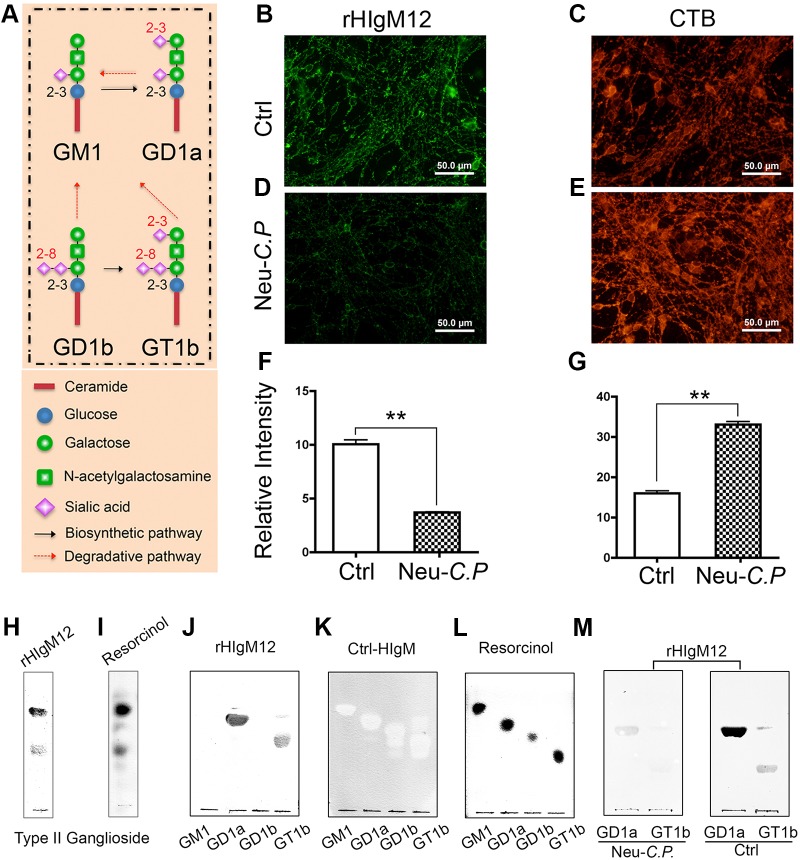
rHIgM12 binds to carbohydrate epitopes of the gangliosides GD1a and GT1b. Because rHIgM12 was identified in part by its strong binding to the surface of neurons, which are rich in gangliosides, we tested whether rHIgM12 could recognize prominent brain gangliosides by chromatography. (A) The three major brain gangliosides, GD1b, GT1b and GD1a, are converted to GM1 by Neu-C.P., which hydrolyzes sialic acid at the α2-8 and terminal α2-3 linkages, whereas internal α2-3 linkages remain unaffected. (B-E) Untreated (Ctrl) cerebellar granule neurons in culture (B,C) and those treated with Neu-C.P. (D,E) were immuno-labeled with rHIgM12 (B,D, green) and cholera toxin B (CTB) (C,E, red), which specifically binds GM1. Scale bars: 50 µm. (F,G) Quantified surface fluorescent intensities of green (rHIgM12, F) and red (CTB, G) indicated that Neu-C.P. treatment decreases rHIgM12 binding by 60%, and increases the binding of CTB twofold (**P<0.01; t-test two-sided). Bars are the mean±s.e.m. of three trials. Purified gangliosides from bovine brain were spotted and separated on silica-based high-performance thin-layer chromatography (TLC) plates and then overlaid with rHIgM12 (H). Two bands were detected by rHIgM12 (H), which were also stained by resorcinol (I). Purified GM1, GD1a, GD1b and GT1b were then run on the same TLC plate and incubated with rHIgM12, a control human IgM or stained with resorcinol. rHIgM12 recognized GD1a and GT1b (J), whereas the control human IgM (K) bound to none. Areas of excluded binding observed after extended incubation with the control IgM indicate the position of gangliosides, confirmed in a resorcinol-stained plate (L). Neu-C.P. treatment of TLC plates spotted with GD1a and GT1b abolished rHIgM12 binding to both gangliosides (M).